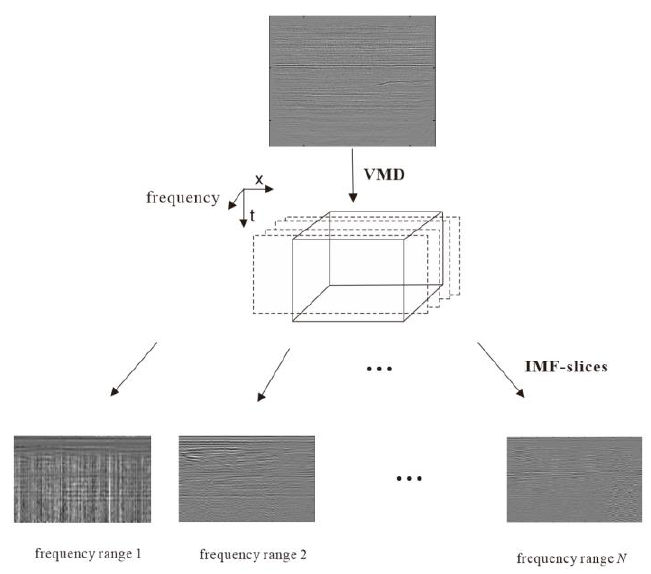
Figure 1. Schematic diagram of IMF-slices.